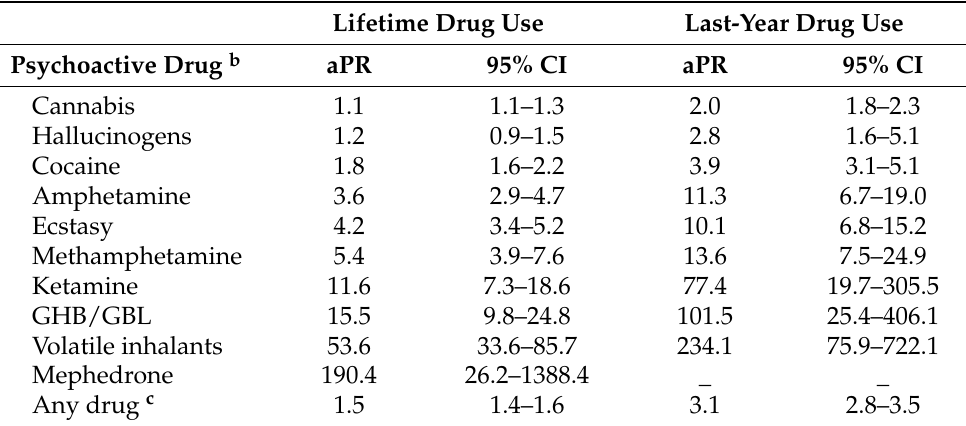
Table 3. Adjusted prevalence ratio (aPR) of psychoactive substance use between men who have sex with men and general-population men in Madrid and Barcelona a ,